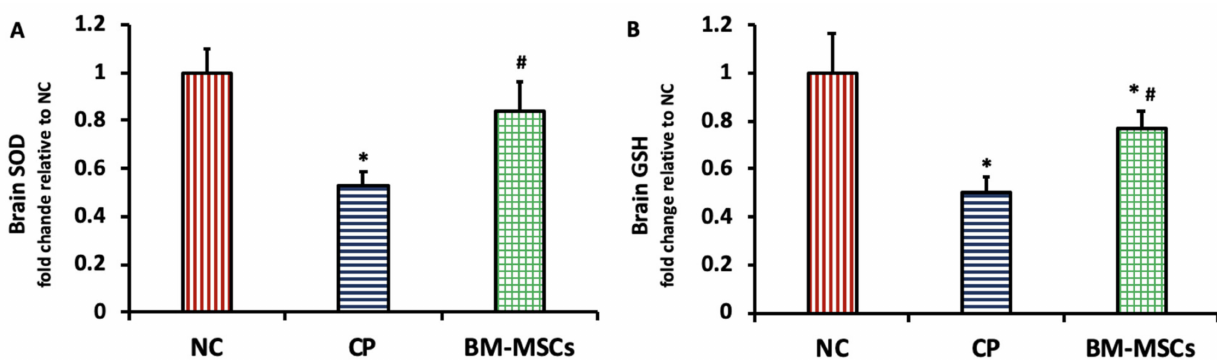
Figure 3. Impact of BM-MSCs injection on MDA ( A ) and NO ( B ) content in the brain tissue of CP-intoxicated rats. Data are presented as mean ± SD, n = 5. * p < 0.05 vs. NC group, # p < 0.05 vs. CP group. NC: normal control, CP: cisplatin, BM-MSCs: bone marrow-derived mesenchymal stem cells, MDA: malondialdehyde, NO: nitric oxide.